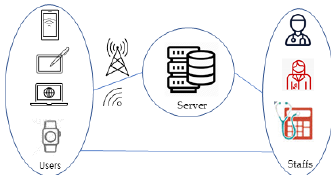
Figure 1. Healthcare support wireless communication environment in the SBAKE protocol. Registration phase: By performing the following steps (Figure 2a), a new U A registers to S